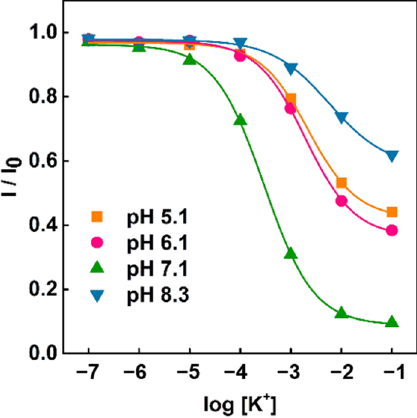
Figure 4. Fluorescence response of the K + -selective nano-optodes at different pH as indicated. Excitation and emission are the same as in Figure 3.